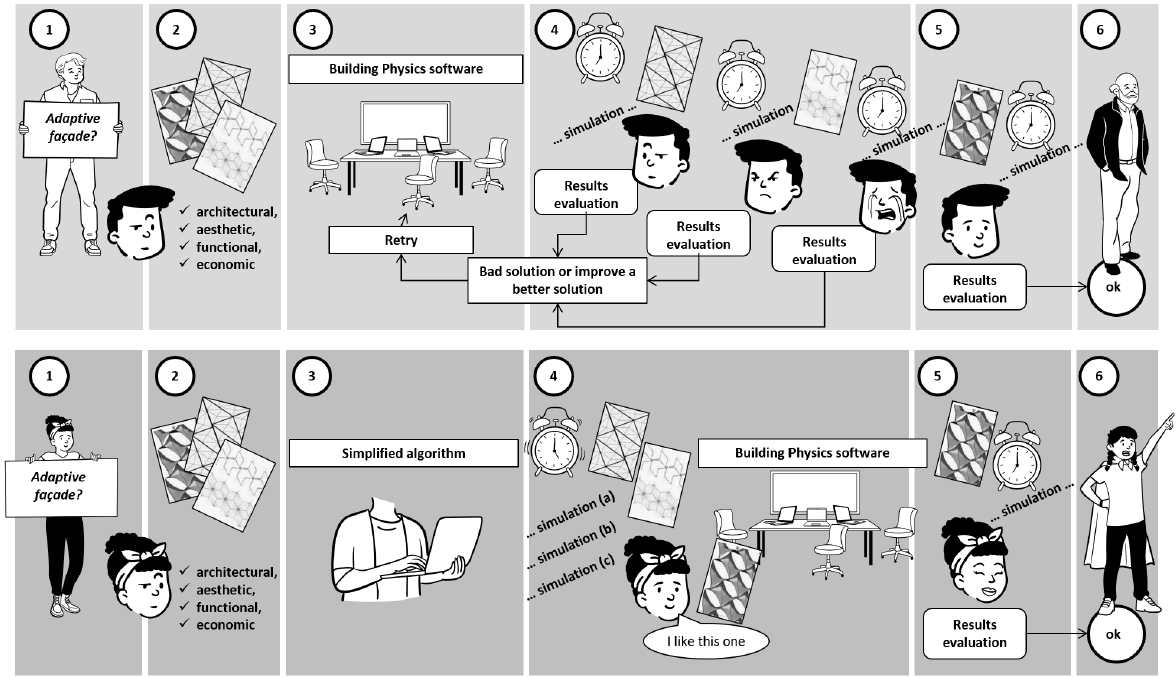
Figure 1. Comparison between standard workflow ( above ) and workflow following the proposed simplified algorithm ( below ). simplified algorithm ( below